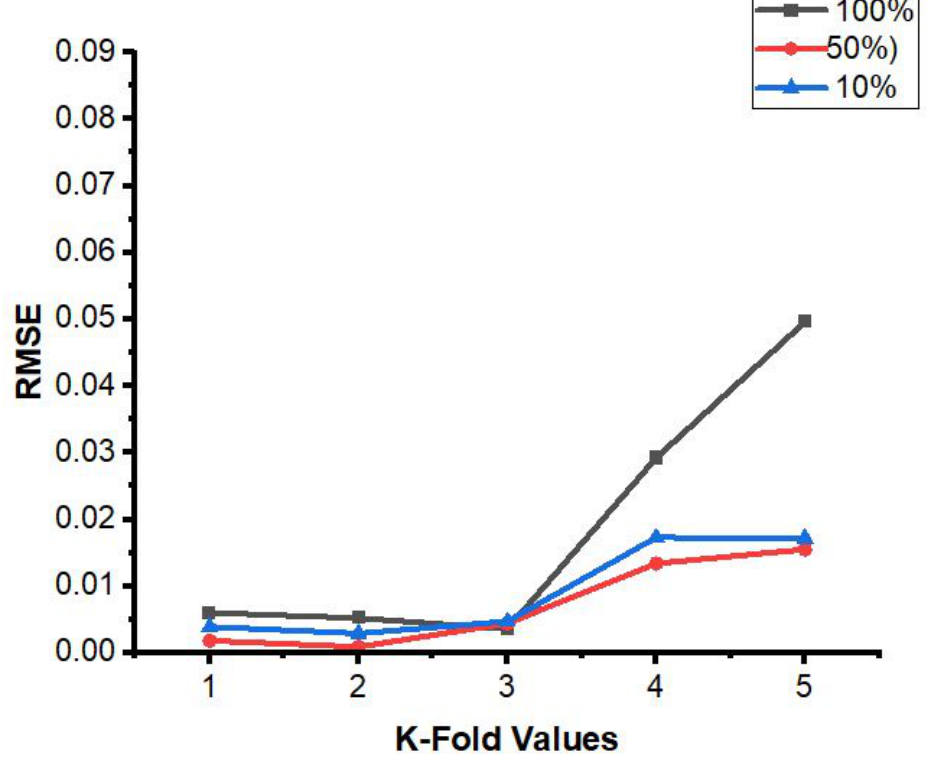
Figure 8. LR model with various humidity levels. Table 6. Various humidity comparison of LR